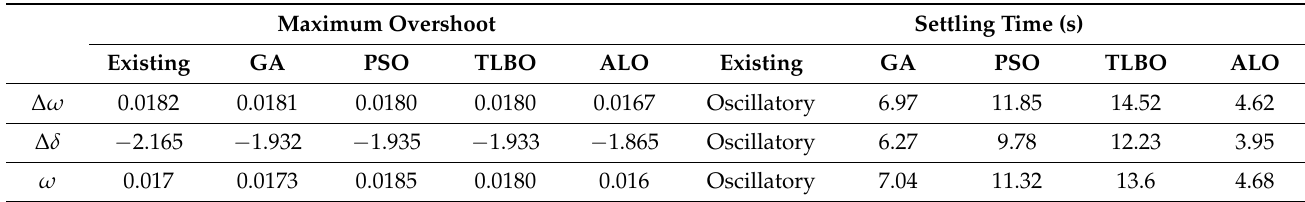
Table 9. Maximum overshoot and settling time of power system